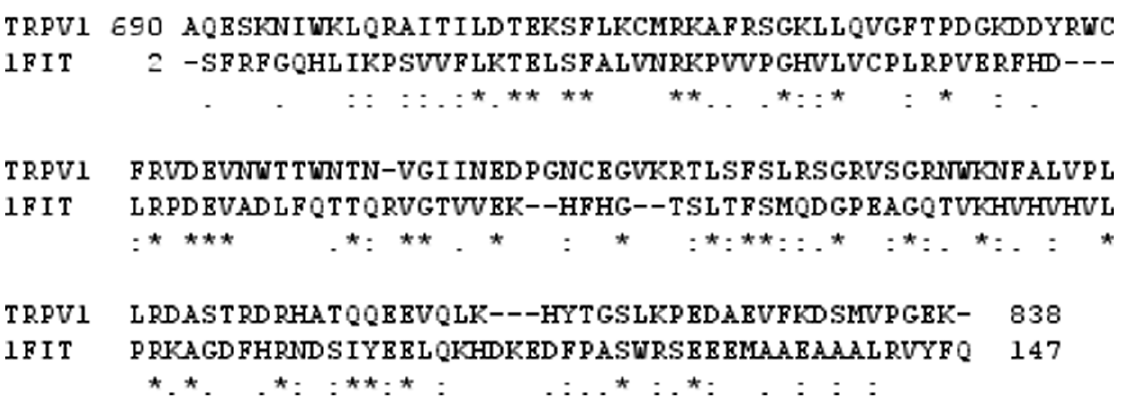
Figure 8. The sequence alignment of the C-terminus of TRPV1 A690 - K838 and the fragile histidine triad protein (FHIT) S2-D150. Identical amino acids are marked with an asterisk. Similar amino acids with the more important groups are indicated with a colon. Dots indicate similar amino acids of the less important groups that are less likely to influence the protein structure.